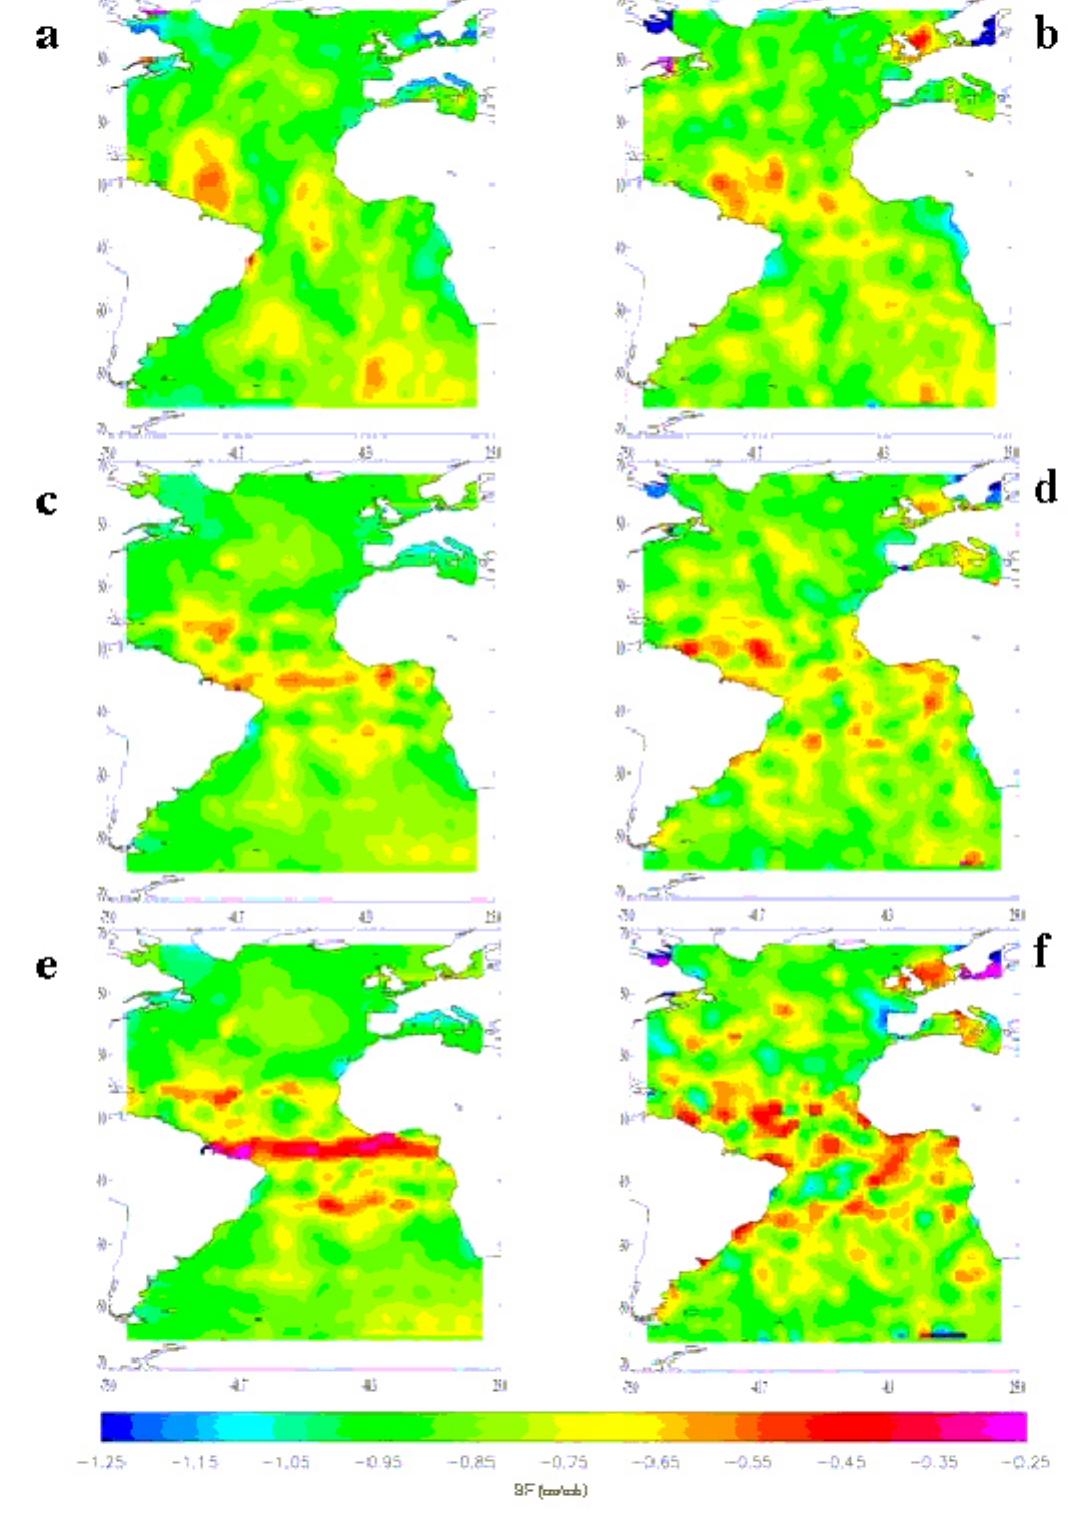
Fig. 11. Comparative between the geographical distribution of BF estimated from the ERS-2 data; (a) 1t = 35days, (c) 1t = 11days and (d) 1t = 35days and the outputs from the barotropic ocean model; (b) 1t = 35days, (e) 1t = 11days and (f) 1t =